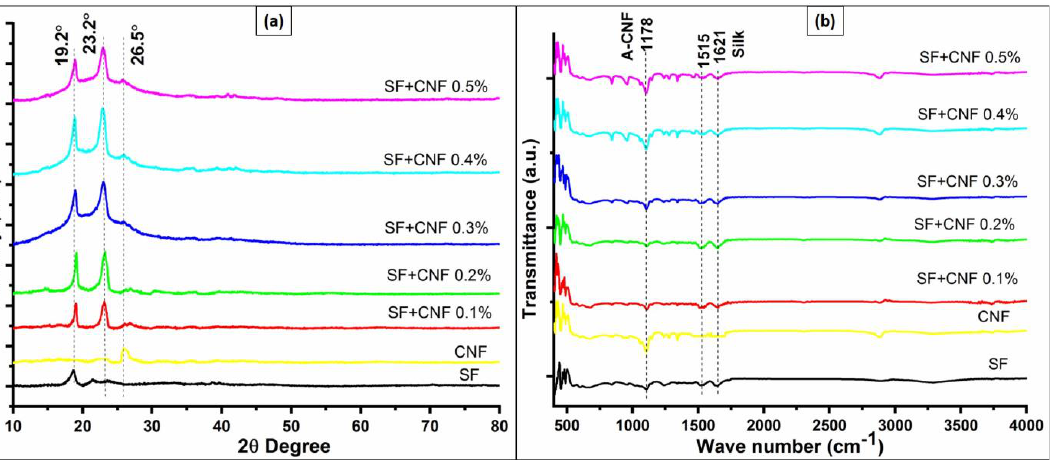
Figure 4. Crystal analysis of the SF sample and the SF sample with CNF nanocomposites in terms of: ( a ) XRD analyses; and ( b ) FTIR analysis. ( a ) XRD analyses; and ( b ) FTIR